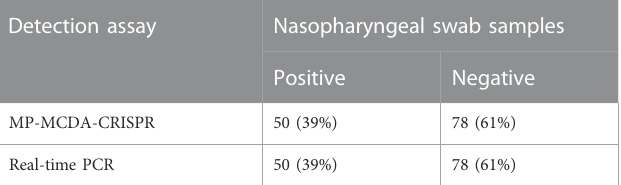
TABLE 3Results comparison ofMP-MCDA-CRISPRassay andreal-timePCR forMP detection in clinical specimens. Detection